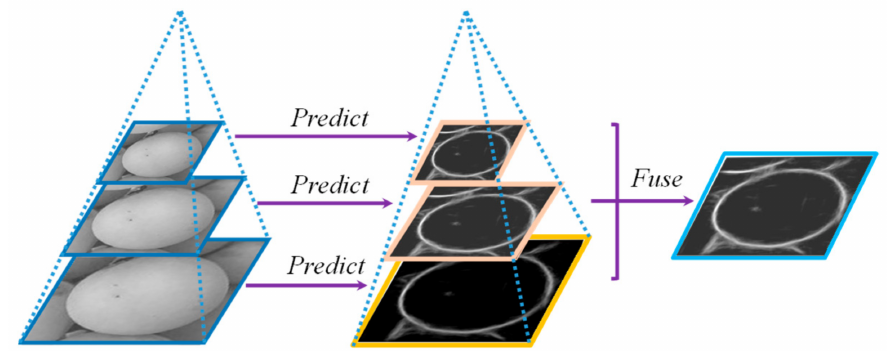
Figure 2. Schematic diagram of multi-scale contour